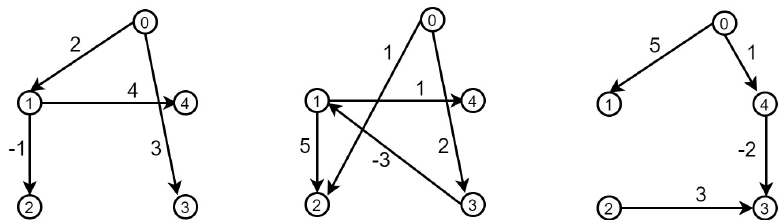
Figure 4. Topology graph among the leader and four agents: G ( ˆ A 1 ) , G ( ˆ A 2 ) , G ( ˆ A 3 ) .